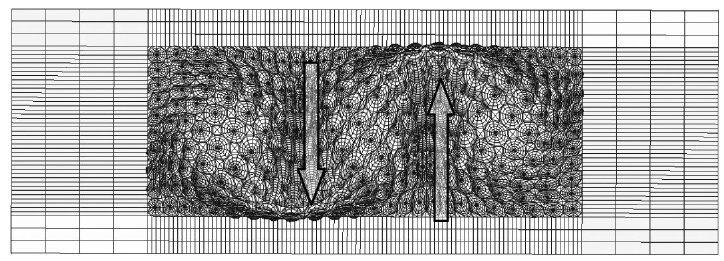
Fig. 45. EIDL 5th mode – 937 Hz – in plane opposite vertical translation.